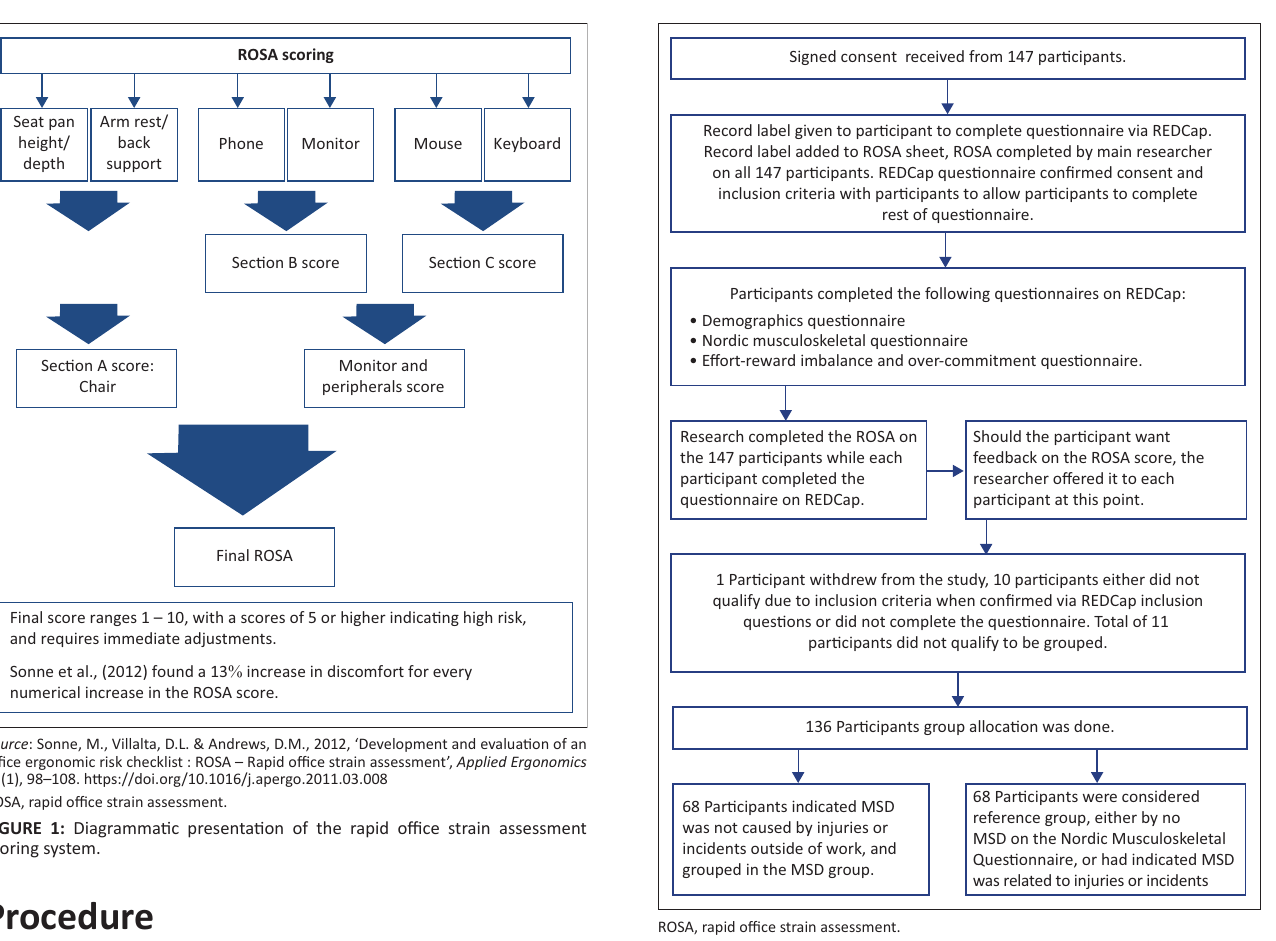
FIGURE 2: Flow diagram of study